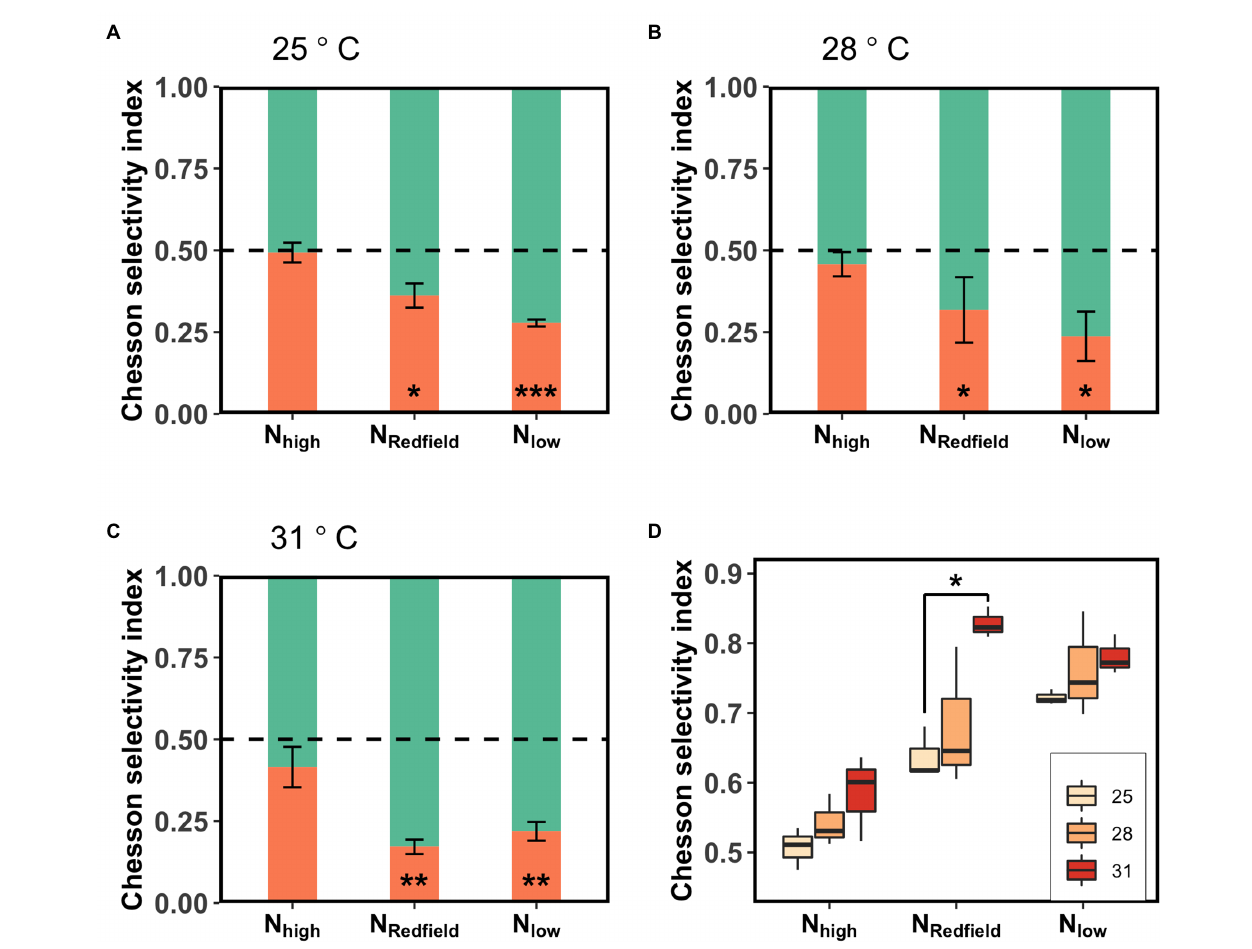
FIGURE 4 | The Chesson selectivity index of Lepidodinium sp. under three different nutrient treatments (N high , N Redfield and N low ) at 25 ° C (A) , 28 ° C (B) and 31 ° C (C) . The green and orange bars represent the Chesson selectivity index towards high-N prey and low-N prey, respectively. The asterisk shows the difference of Chesson selectivity index from 0.5 (Student’s t -test; * p < 0.05; ** p < 0.01; *** p < 0.001; and ns: p > 0.05). The data grouped by nutrient treatments was showed in (D) . The asterisk indicates the significant difference between two temperatures (Tukey HSD Test following a one-way